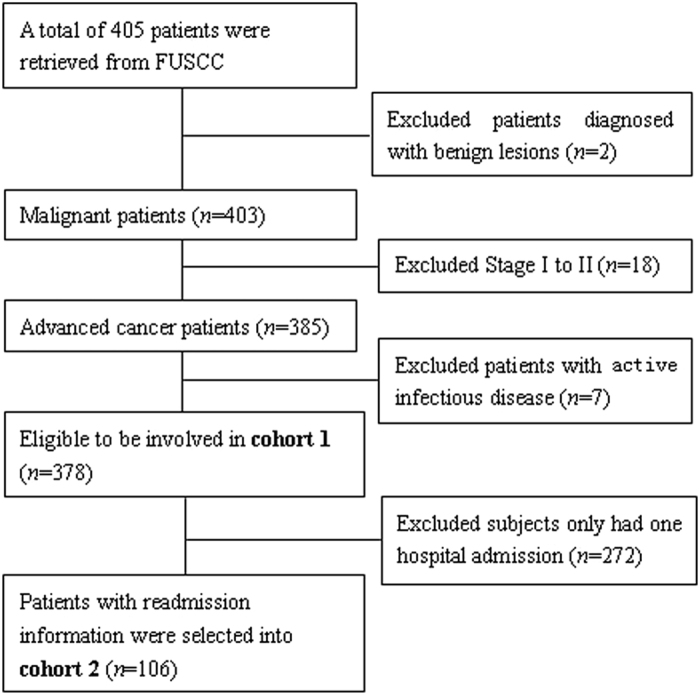
Flow chart of patients excluded from the study.